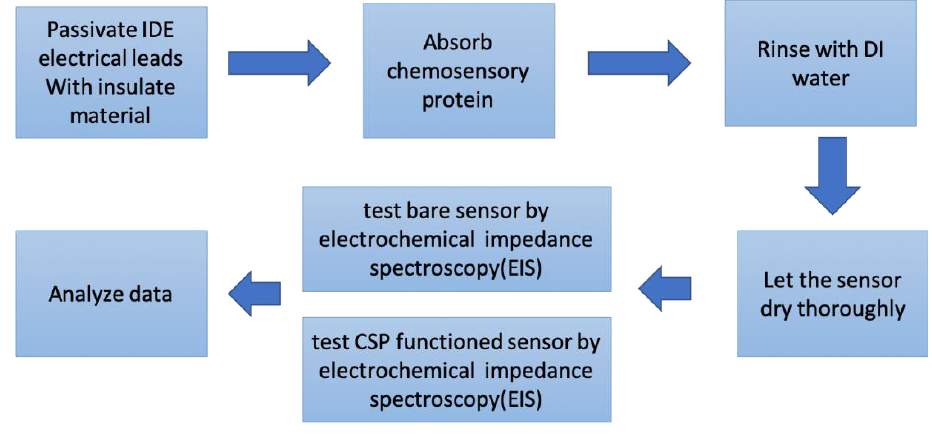
Figure 2. Test procedure.